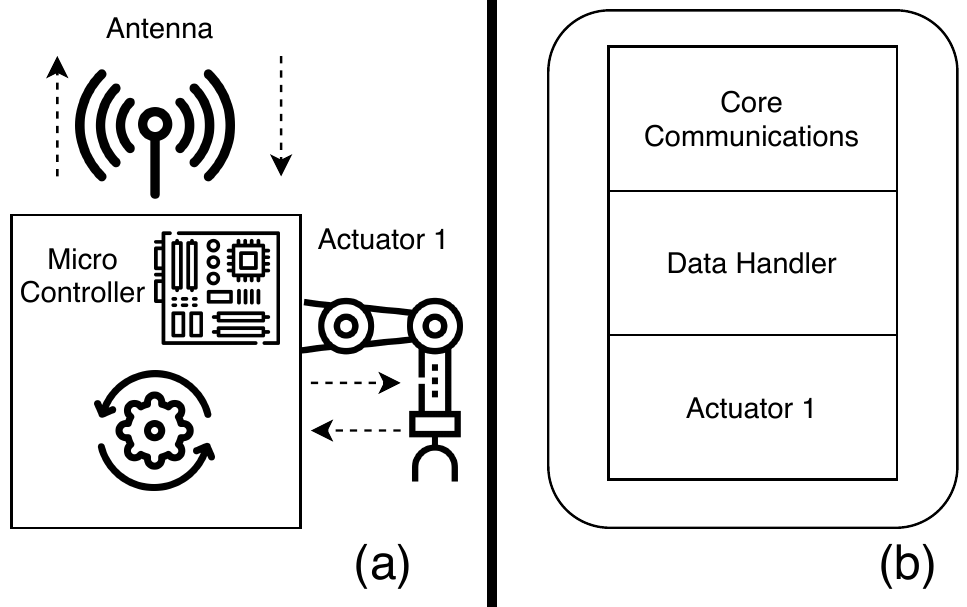
Figure 12. The implementation of the control subsystem: ( a ) A conceptual model of a control module. Similarly to the monitor subsystem, the data are read, processed, and transmitted to the point of interest. However, the main difference is that the module also receives instructions, which it